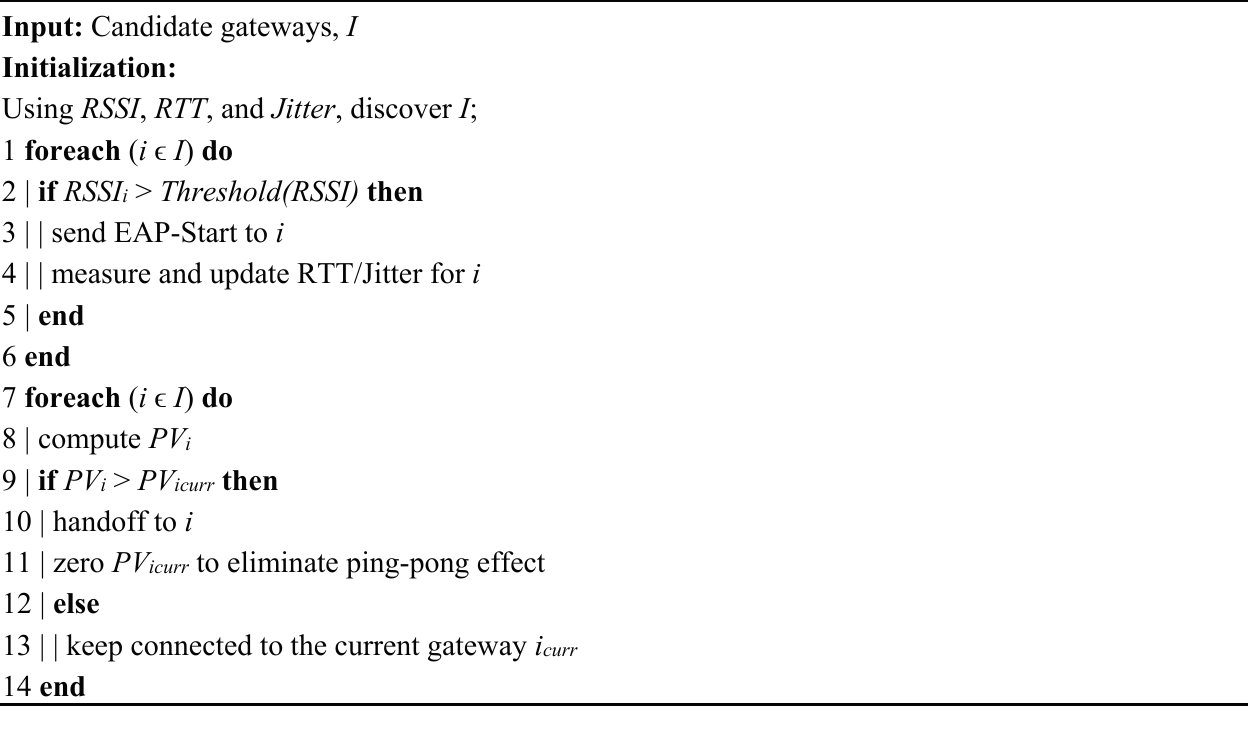
Algorithm 1 Gateway Selection based on RSSI, RTT, and